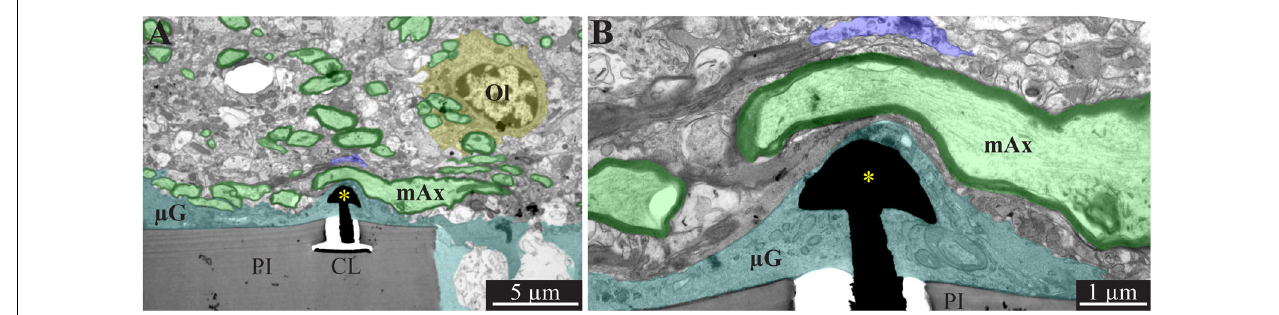
FIGURE 5 | A low and high magnification, transmission electron microscope image of the interfaces formed between a gold mushroom shaped microelectrode extending from a polyimide platform implanted for 4 weeks and the surrounding cortical tissue. The mushroom shaped microelectrode (black) emerges from the PI substrate (gray). Note the thin layer of dark microglia (cyan in A,B , and unmarked dark gray branches in B ) adheres tightly to the gM µ E and PI substrate. The parenchyma around the implant underwent regenerative processes as indicated by the large number of myelinated axons (green and black envelope) and the presence of oligodendrocytes in the immediate vicinity of the implant (yellow). Whereas, axonal branches with a relatively large diameter ( ∼ 3 µ m) extended close to the gM µ E, it is conceivable that the adhering microglia (and in this instance the myelin as well) insulated the electrode from the surrounding excitable tissue. PI, polyimide ribs; CL, conducting line; gM µ E, yellow asterisks; Ol, oligodendrocyte; µ G, microglia; mAx, myelinated axons. Note an unmarked copy of this figure is presented as Supplementary Figure 6